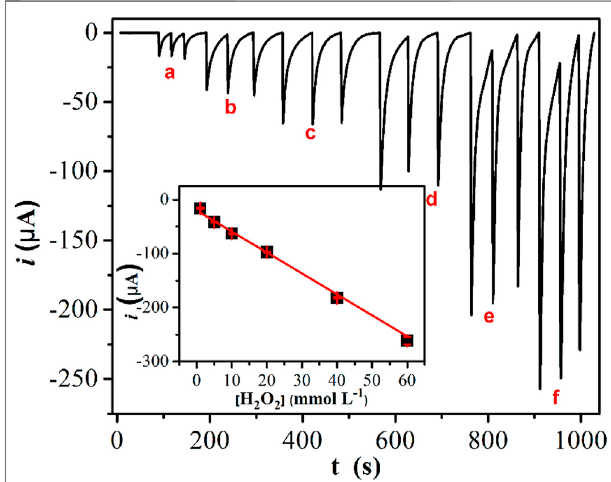
FIGURE 7 | BIAgram constituted by triplicated injections of increasing concentrations of H 2 O 2 [a) 1.0 × 10 – 3 mol L − 1 ; b) 5.0 × 10 – 3 mol L − 1 ; c) 1.0